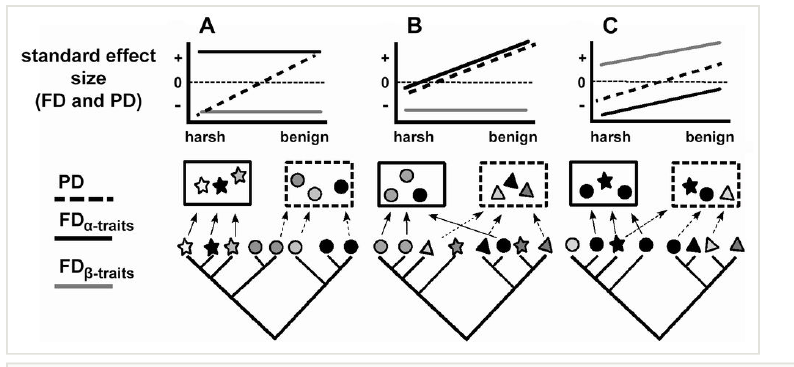
Hypothetical examples where PD shows the pattern predicted by the SDH, but FD α - traits and FD β -traits show that the SDH is not supported. For each example (A-B), individual species are represented by symbols at the tips of the phylogenetic tree; the shape of the symbols represents beta traits, the color of the symbols represents alpha traits, and communities are represented by rectangles. In each example, we show two communities, one at the stressful and one at the benign end of the stress gradient. In case A, both alpha and beta traits are labile on the phylogeny, and looking at these traits would suggest that there is not a shift from environmental fi ltering to competition along the stress gradient. In case B, the alpha trait is phylogenetically conserved but the beta trait is not, so while the PD pattern appears to support the SDH, the beta trait pattern shows that there is no change in the importance of environmental fi ltering along the gradient. In case C, the expected PD pattern is generated from strong competition causing competitive exclusion and clustering of FD α -traits at the harsh end of the gradient and environmental heterogeneity and fi ne-scale environmental fi ltering causing overdispersion of FD β -traits at the benign end of the